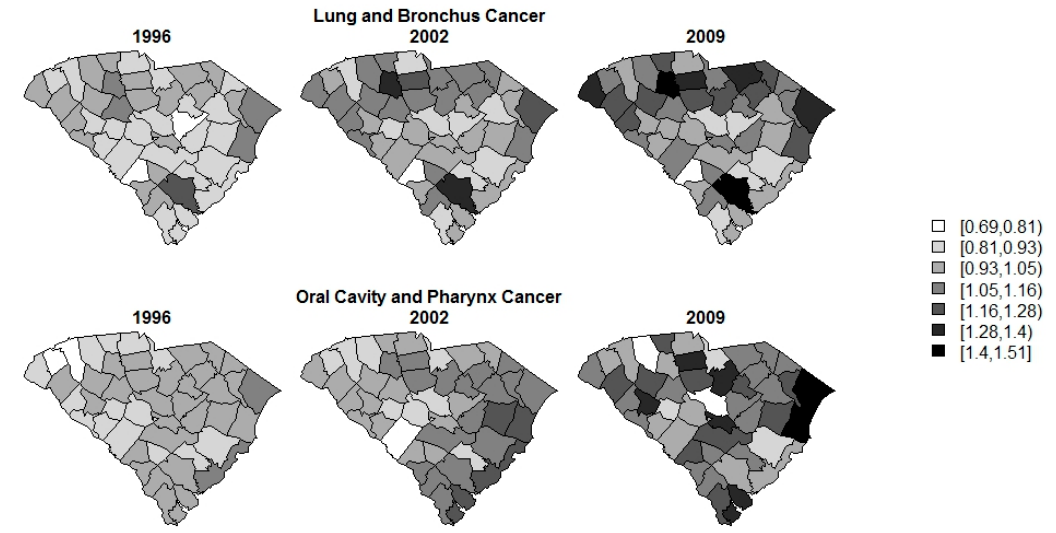
Figure 5. Overall posterior mean risk estimate ( θ ij ) for lung and bronchus cancers, as well as oral cavity and pharynx cancer from model Alt2B for a selection of years.